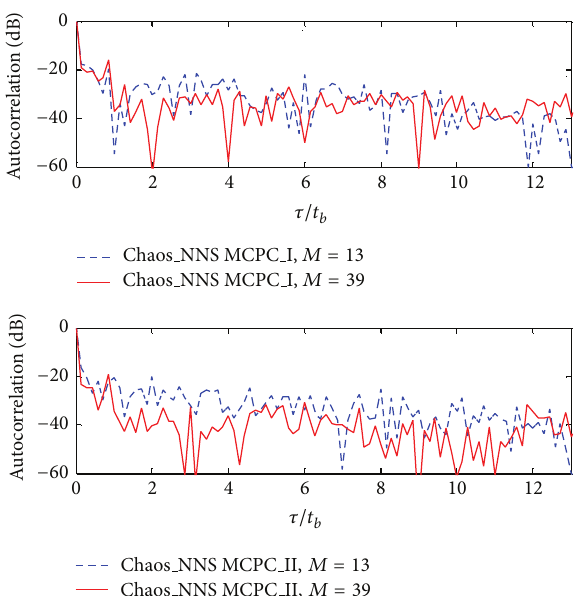
Figure 9: Influence of bit number on autocorrelation.